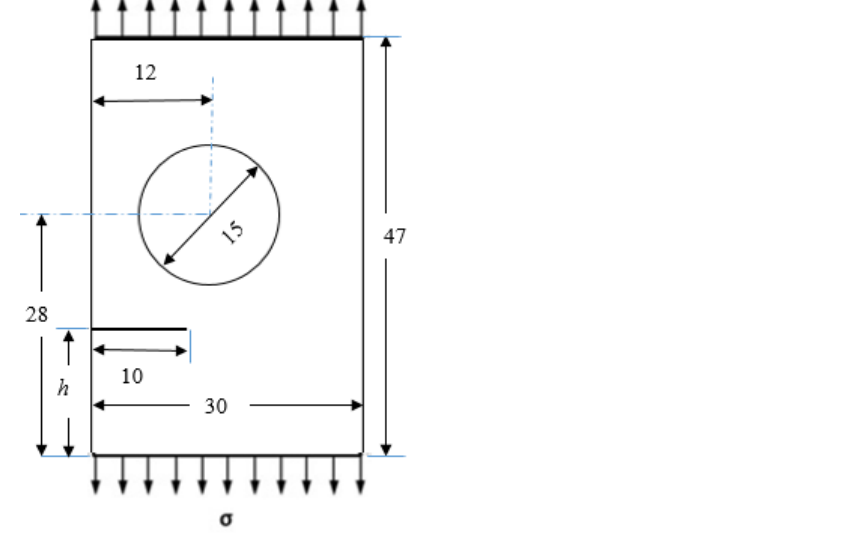
Figure 17. Geometrical dimension for the plate with a circular hole and edge crack (all dimensions in mm).